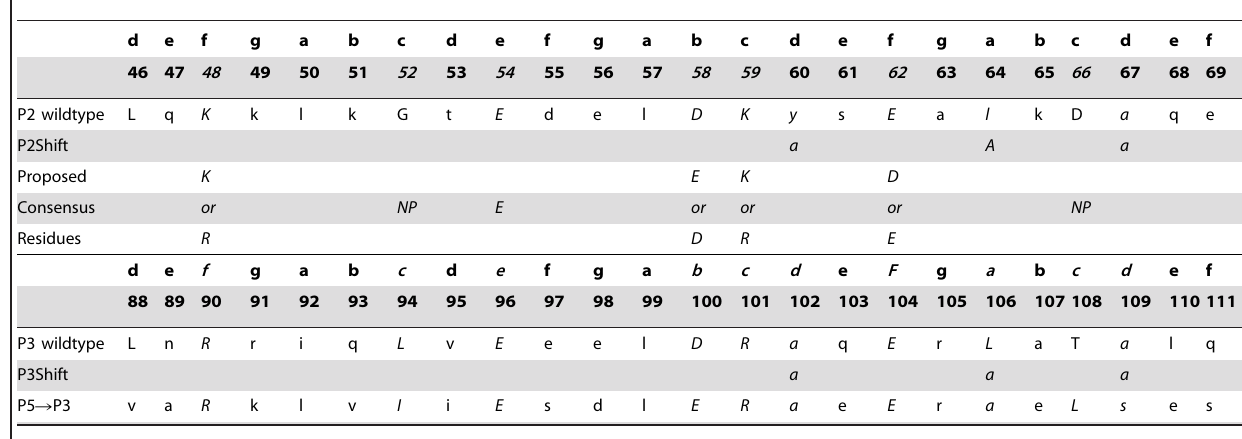
Table 1. Tropomyosin period 2 and period 3 cluster and period shift